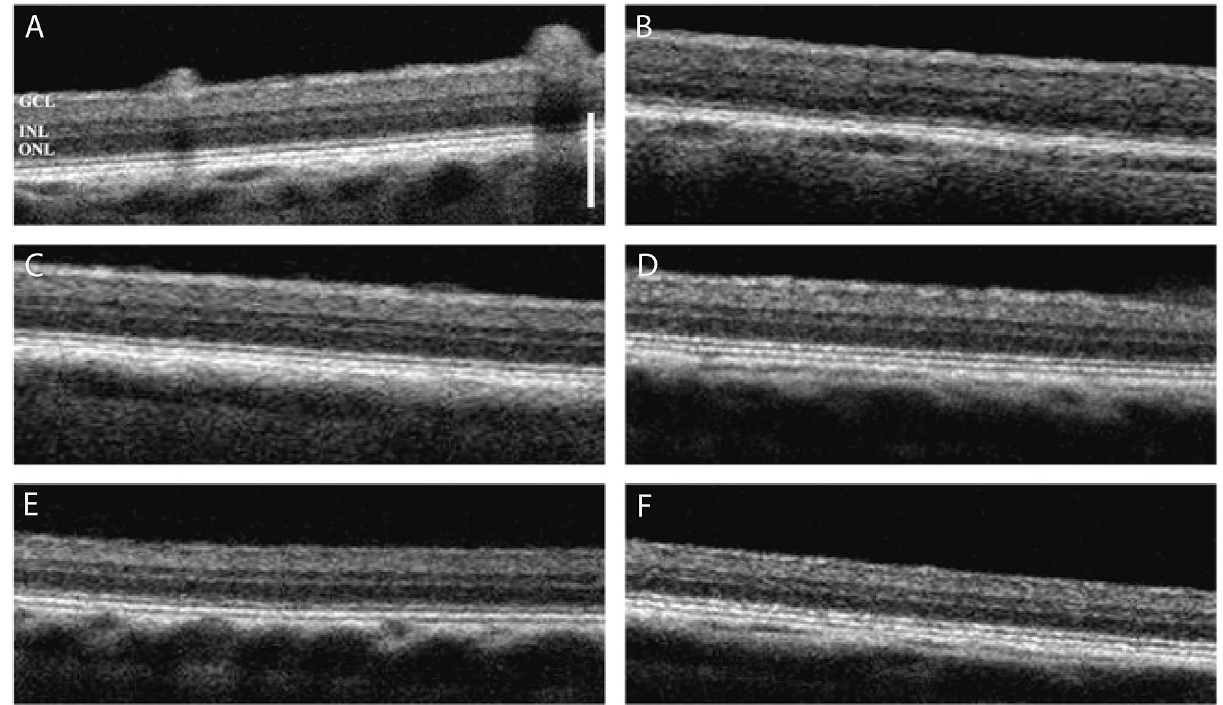
Figure 1. Representative optical coherence tomography (OCT) scans of the right eye in each experimental pig ( A – F ). The images show no morphological alterations of the retina. GCL, ganglion cell layer; INL, inner nuclear layer; ONL, outer nuclear layer. The structural organization of the retina is normal in all experimental animals. Scale bar, 250